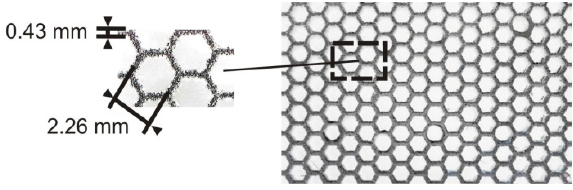
Figure 9. Sample’s characteristic dimensions.